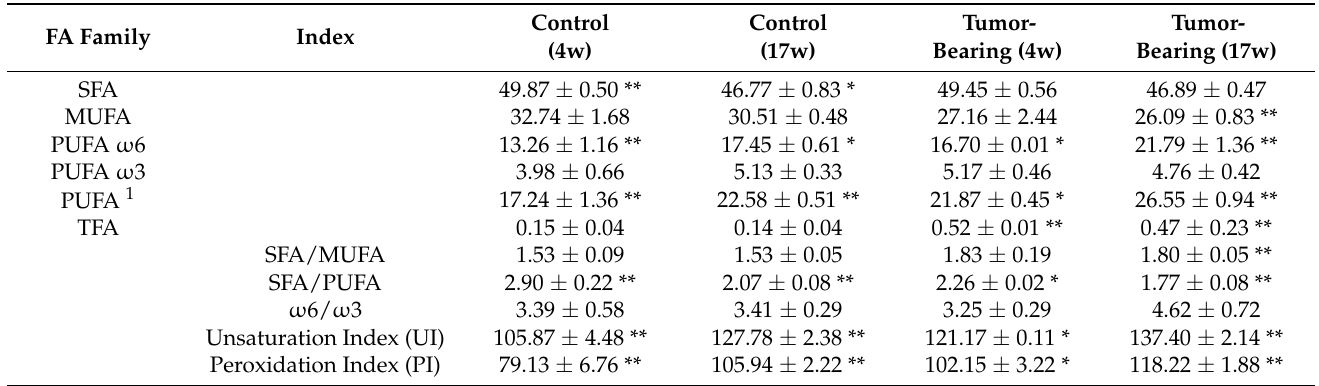
different ages 1 Table 3. Relative quantitative percentages (% rel. quant.) of fatty acid methyl families and ratios/in-